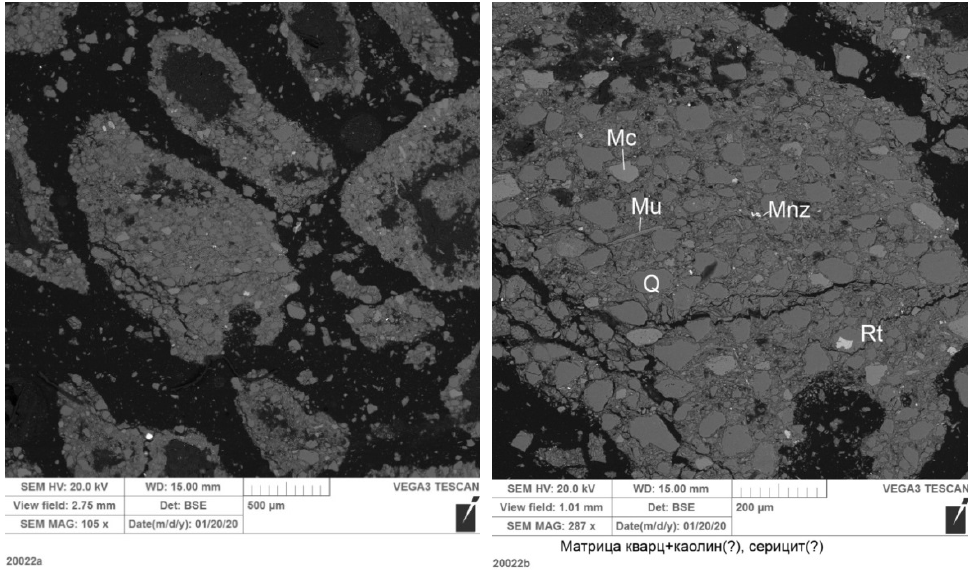
Figure A3. SEM micrograph of Sample GGS2-11-3. Fragments of quartz (Q), potassium feldspar (Mc), muscovite (Mu) in clay